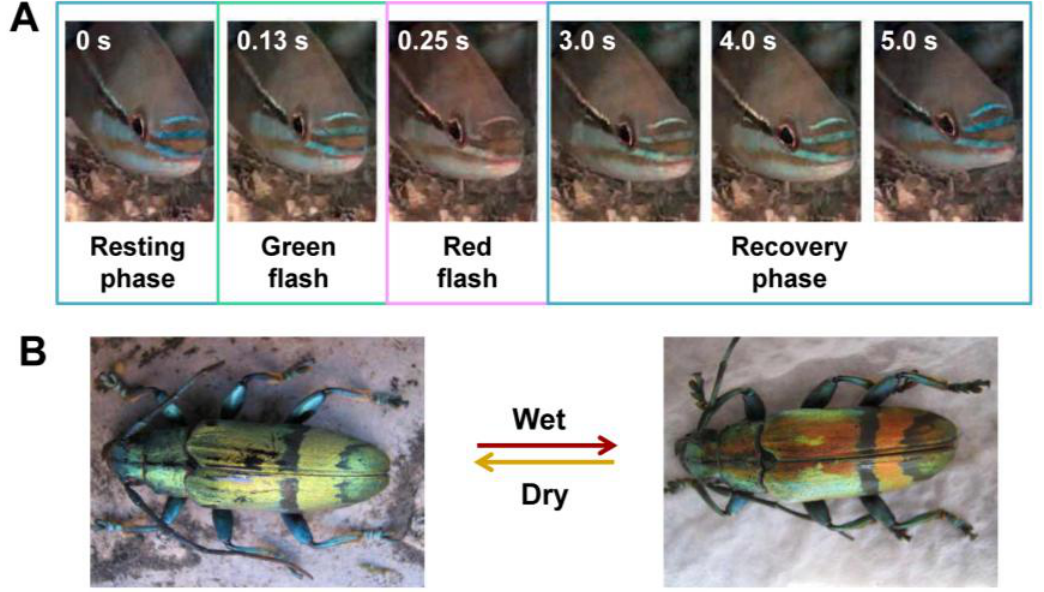
Figure 4. Natural creatures with tunable structural colors. ( A ) Structural color changes of the facial stripes in a paradise whiptail from blue to red through green and back to blue via yellow and green in 5 s [22]. ( B ) Structural color switches of the beetle Tmesisternus isabellae from gold in dry state to red in wet state